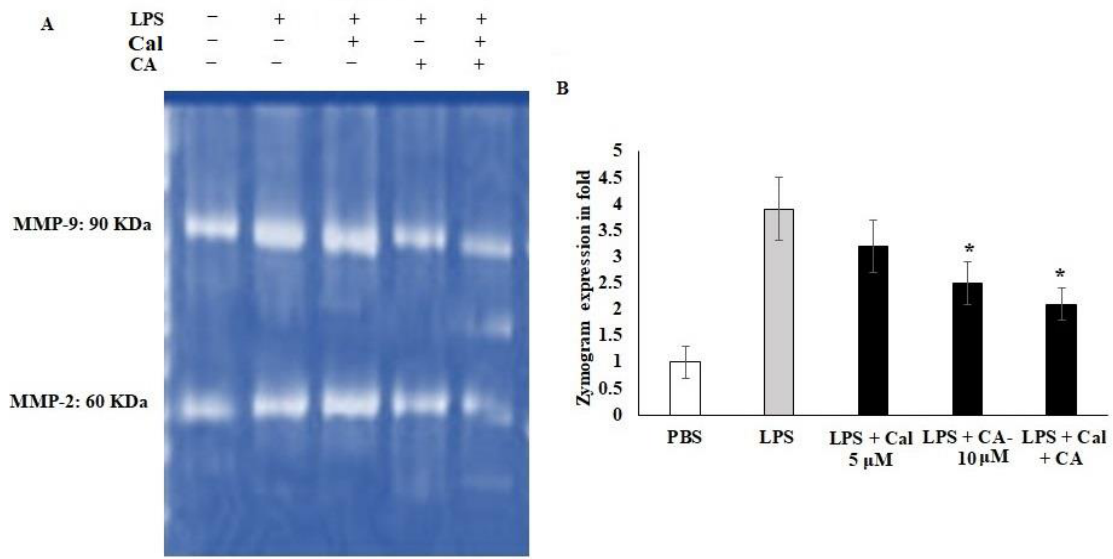
Figure 5. CA and Cal inhibit MMPs in LPS-induced HCT116. ( A ) CA and Cal inhibit the MMP-2 and MMP-9 activity in HCT116 cells. The activity was demonstrated by gelatin zymography method. ( B ) CA- and Cal-supplemented HCT116 cells were used to quantify the MMP-2 and MMP-9 activity. Data were obtained from three separate experiments and expressed as mean ± SEM. * p < 0.05 represents significance compared to treated group (CA and Cal) against PBS (untreated group